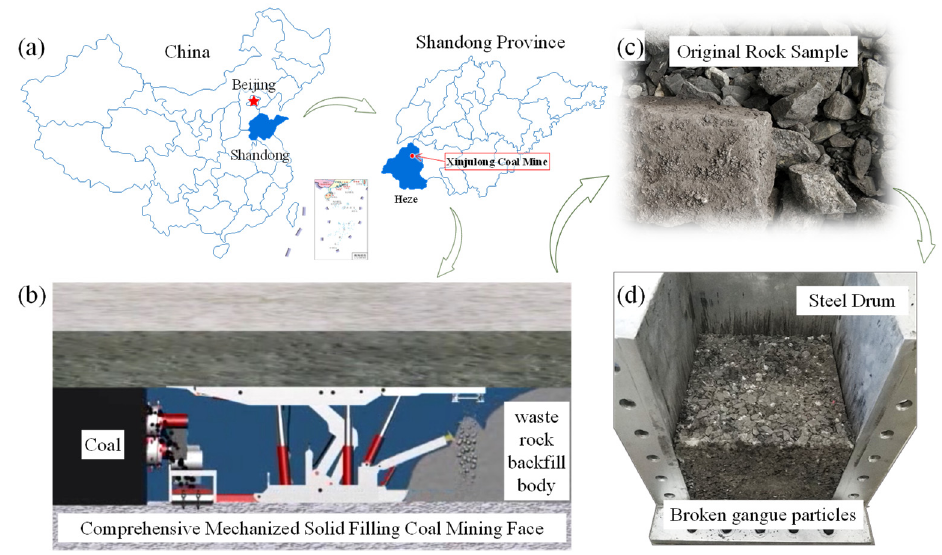
Figure 2. Specimen collection site and gangue particles: ( a ) is the location of the specimen collection site for Xinjulong coal mine; ( b ) is a schematic diagram for the application of gangue in the working face; ( c ) is the original specimen collected; and ( d ) is the gangue specimen in the test of this paper. The minimum inner diameter of the steel barrel size is 200 mm. In order to reduce the than 1/5 of the steel barrel size, that is, 30 mm particles. The specific preparation processes are as follows: (1) Weigh 12.8 kg gangue raw materials; (2) crush the raw materials